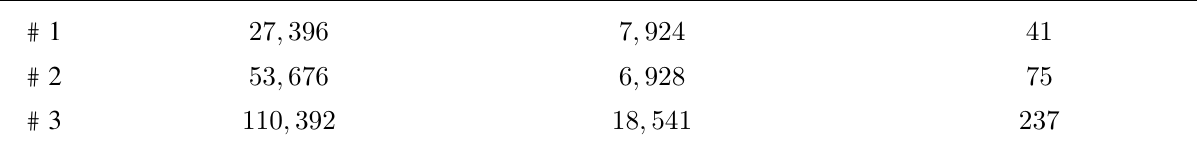
Table 1. Segmentation Results of 3D Data Sets of Blaise Pascal University.